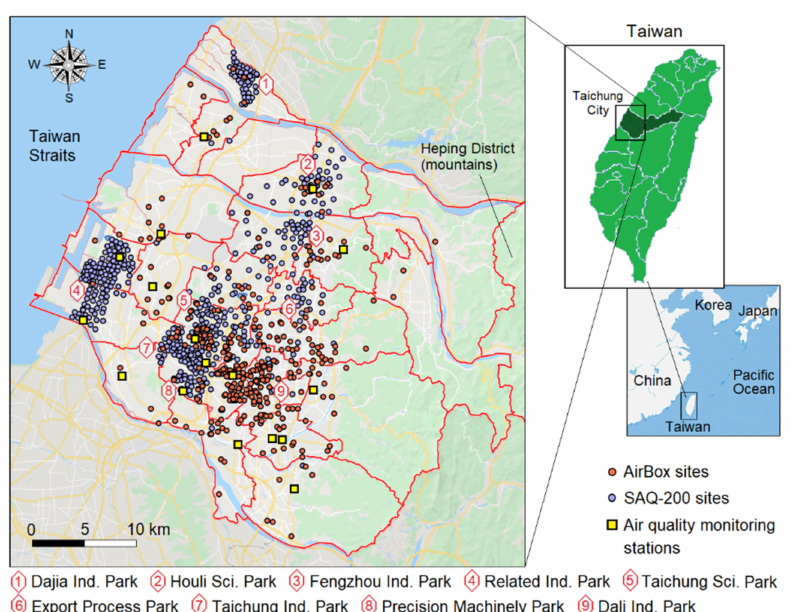
Figure 1. Location of AirBox, SAQ-200, and air quality monitoring stations (AQMSs) sites in Taichung City, where most SAQ-200 sensors are located in industrial parks. The red line is the administra- tive boundary.